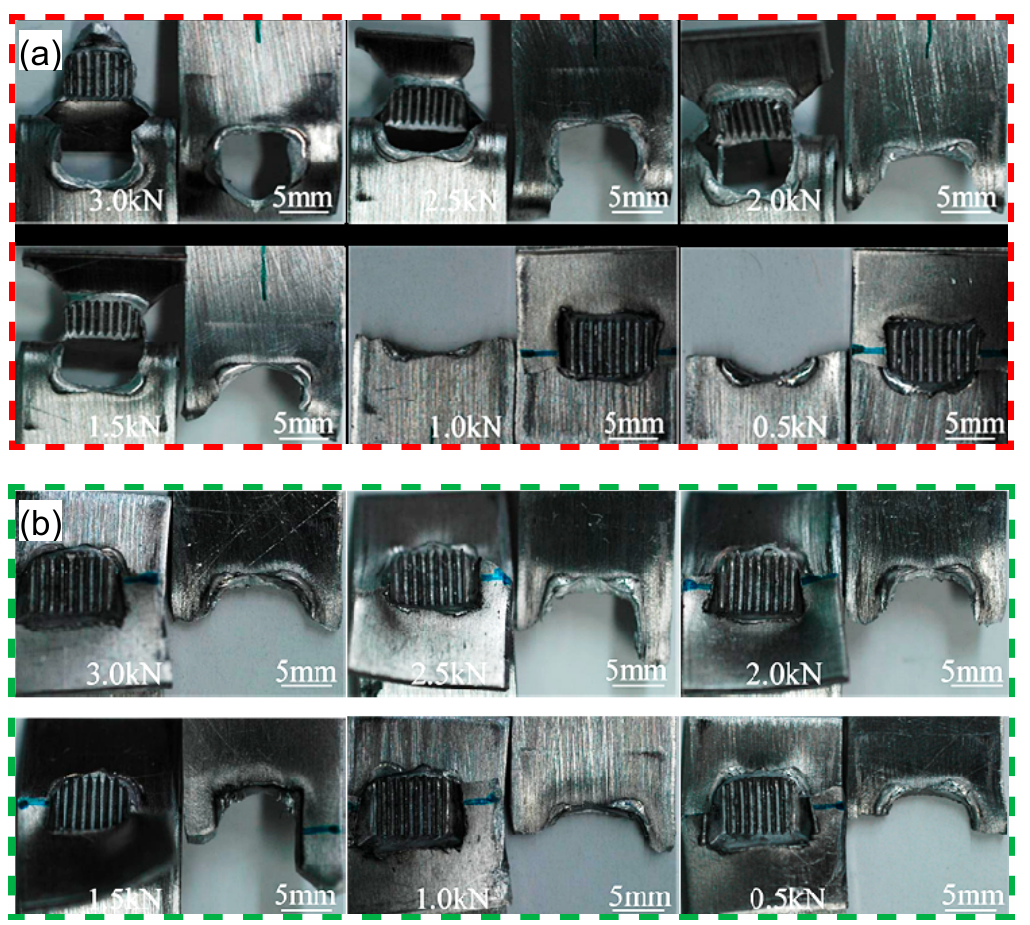
Figure 7. Macroscopic images showing the fatigue failed samples of the USWed 6022-T43 Al alloy joints tested in the conditions of ( a ) 1400 J-(3.0 – 0.5) kN and ( b ) 2000 J-(3.0 – 0.5) kN.